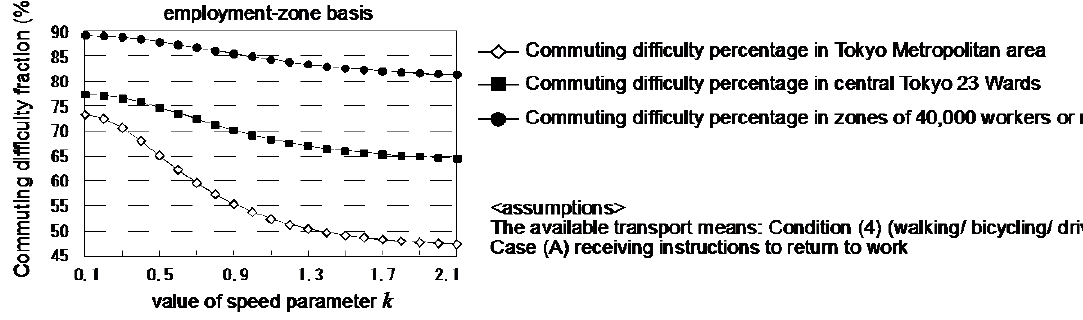
Figure 14. Ratios between speed parameter ( k ) and percentages of commuting